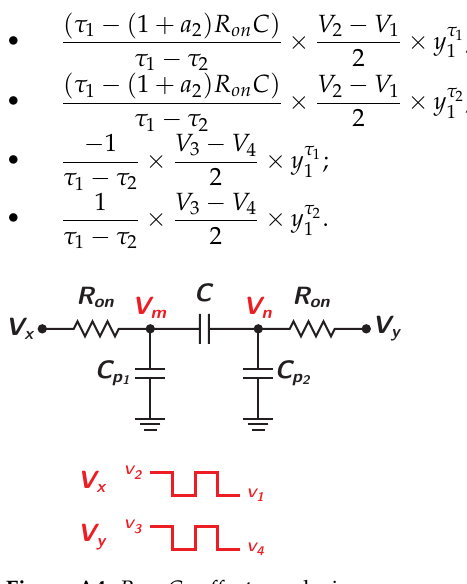
Figure A4. R on , C p effects